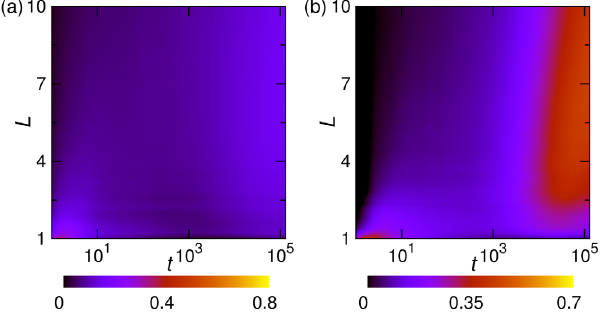
FIG. 12. Cross-correlation of local potential energy and dy- namics heterogeneity. Cross-correlation of local potential energy ¯ E at different coarse-graining length L and the dynamic propen- sity h Δ r i at different time t for (a) 2D polydisperse system ( Δ ¼ 11% ) at T ¼ 2 × 10 − 3 and (b) the 2D binary system at T ¼ 1 . 5 × 10 − 3 . For the ease of comparison, we have used the same color bars as Figs. 4(a) and 4(d) for polydisperse and binary systems,